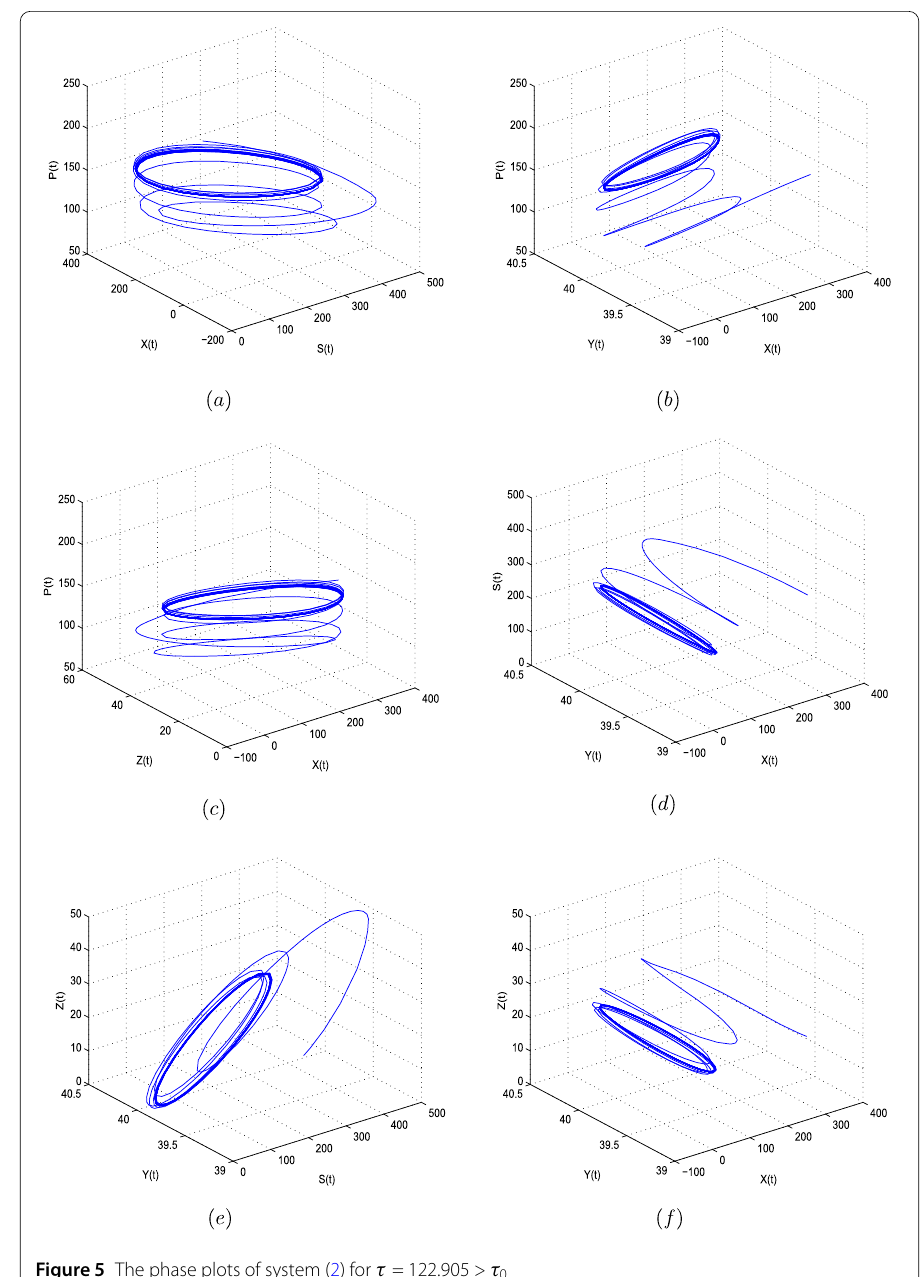
Figure 5 The phase plots of system (2) for τ = 122.905 > τ 0